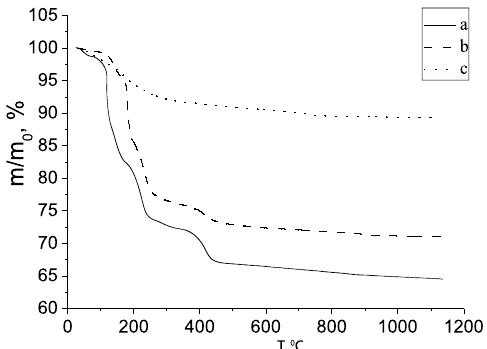
) HPO and Ca(NO 4 2 4